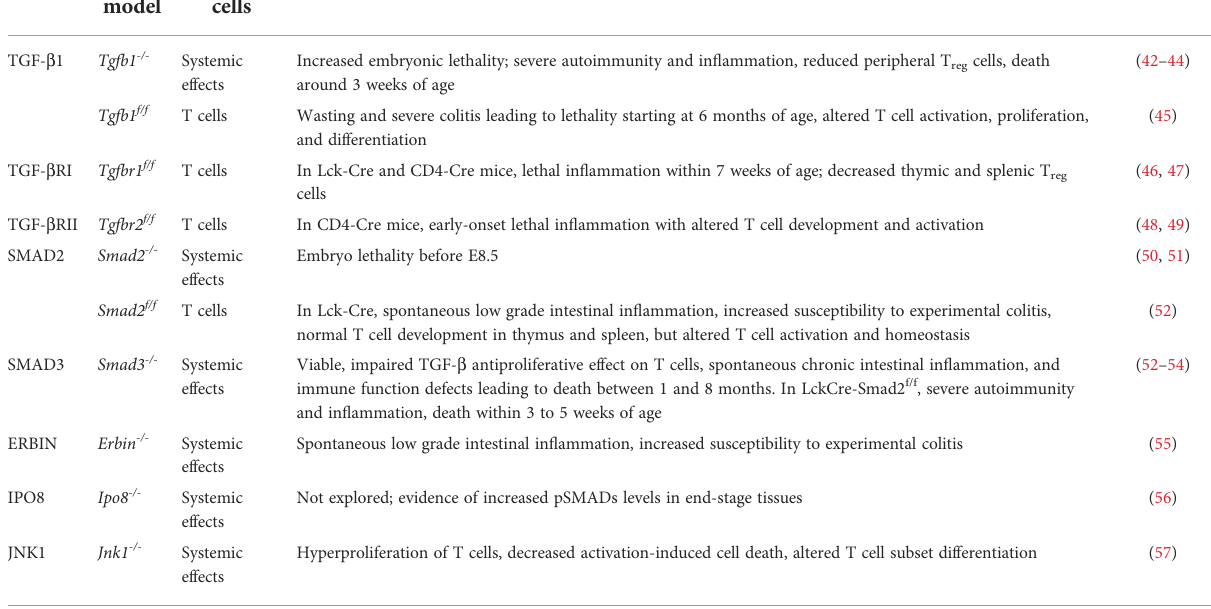
TABLE 2 Mouse models for the study of immune dysregulation in TGF- b